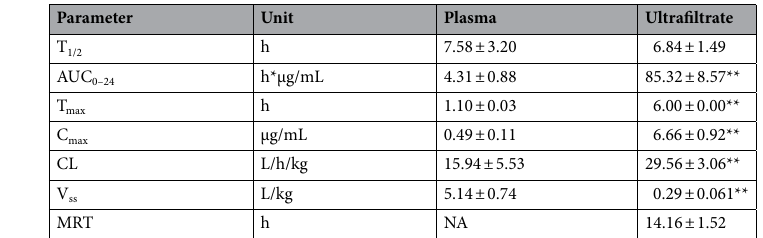
Table 2. PK parameters for DAN in plasma and ultrafiltrate after i.m. administration at a dose of 2.5 mg/ kg ( n = 6). T 1/2 : elimination half-life of the drug; AUC 0–24 : area under the curve of plasma or ultrafiltrate concentration–time; T max : the time point of maximum plasma concentration of the drug; C max : the maximum plasma concentration; CL: body clearance; V ss : volume of distribution at steady state; MRT: mean residence time; NA: not applicable.** P ˂ 0.01 for comparison of plasma and ultrafiltrate.